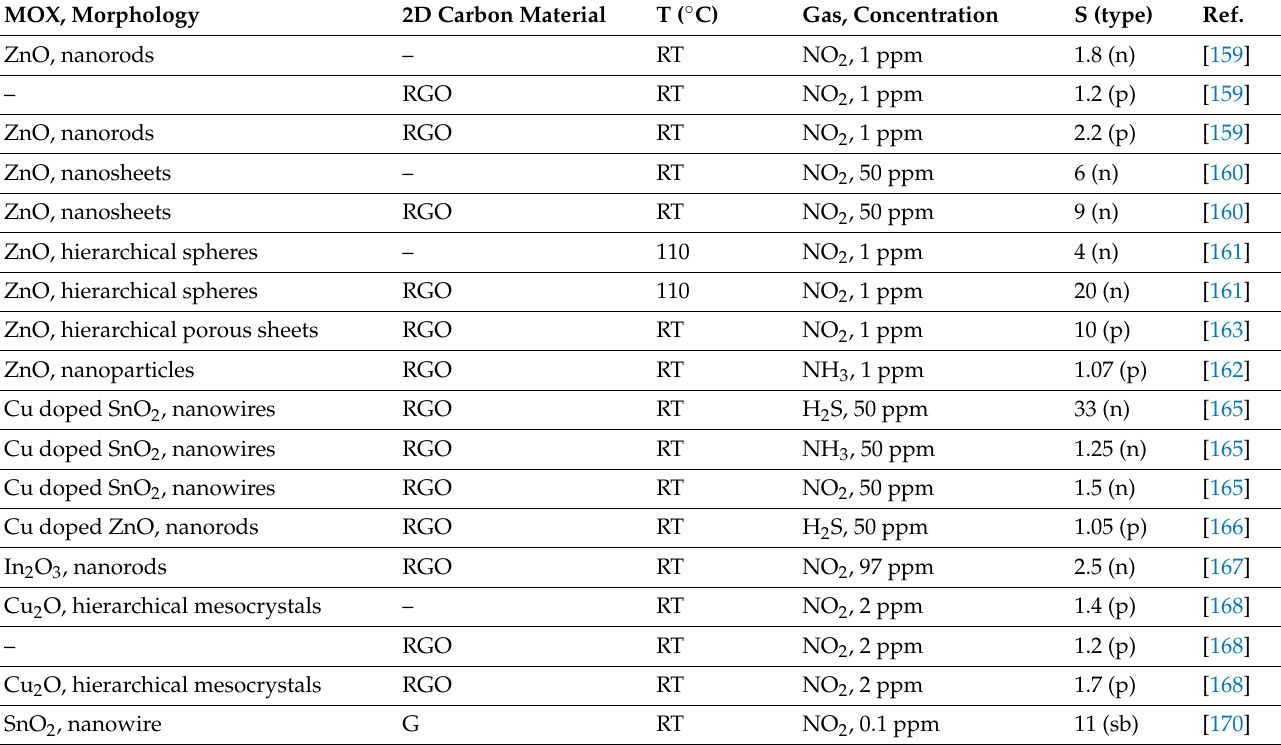
Table 6. Chemiresistors exploiting composite materials based on metal oxide (MOX) and 2D carbon nanostructures, namely graphene (G) and reduced graphene oxide (RGO). The response intensity S is calculated as S = R gas /R air for NO 2 and as S = R air /R gas for other compounds in the case of n-type sensing response. The contrary is in the case of p-type sensing response. The n- or p- type response is reported in the S column. In this column, ‘sb’ stands for the response arising from the metal–semiconductor Schottky barrier modulation (Equation (11)). Gas concentrations are expressed in parts per million (ppm); the sensor temperature is T; ‘RT’ stands for ‘room